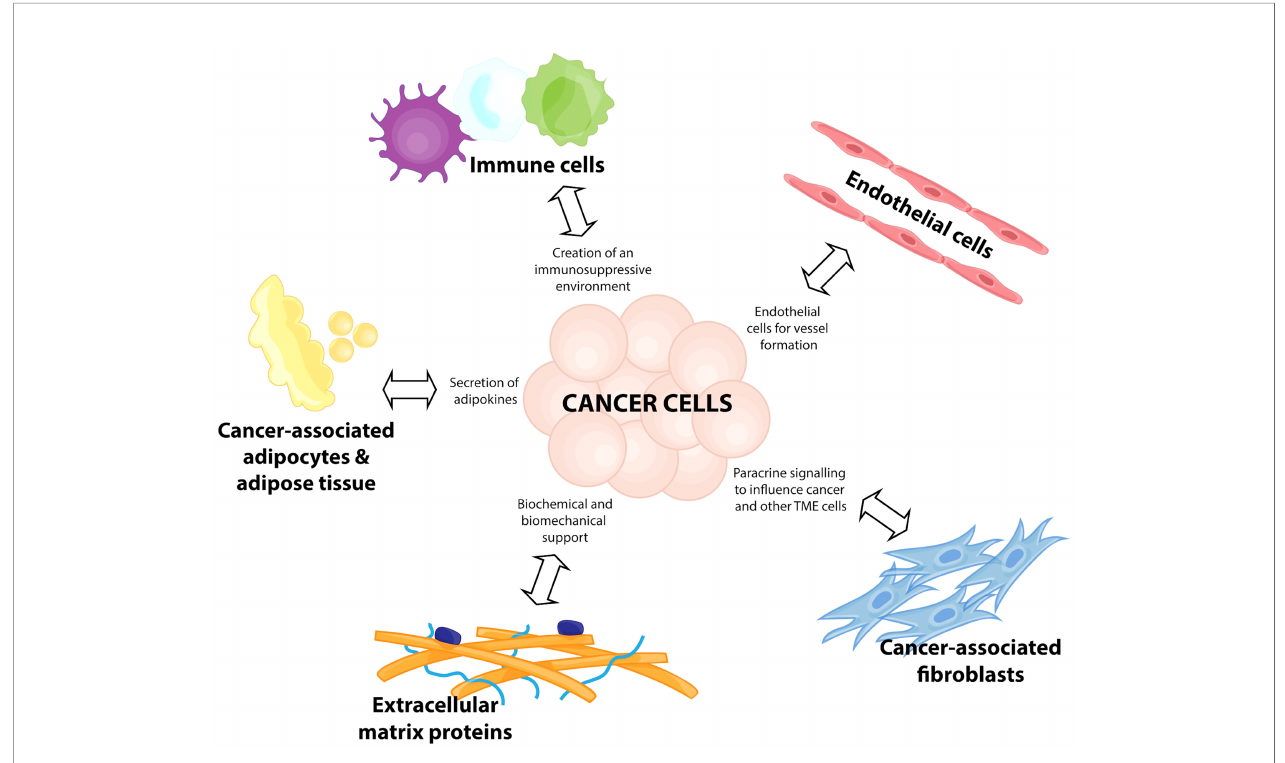
FIGURE 1 | Components of a breast cancer tumor microenvironment. Breast cancer disease progression relies on a complex network of cells and interactions, termed the tumor microenvironment (TME). This consists of immune cells for the creation of an immunosuppressive environment, recruitment of endothelial cells for vessel formation, transformation of cancer-associated fi broblasts to participate in paracrine signalling to in fl uence the cancer cells and other TME cells, release of adipokines from cancer-associated adipocytes and adipose tissue, and the biochemical and biomechanical support from extracellular matrix